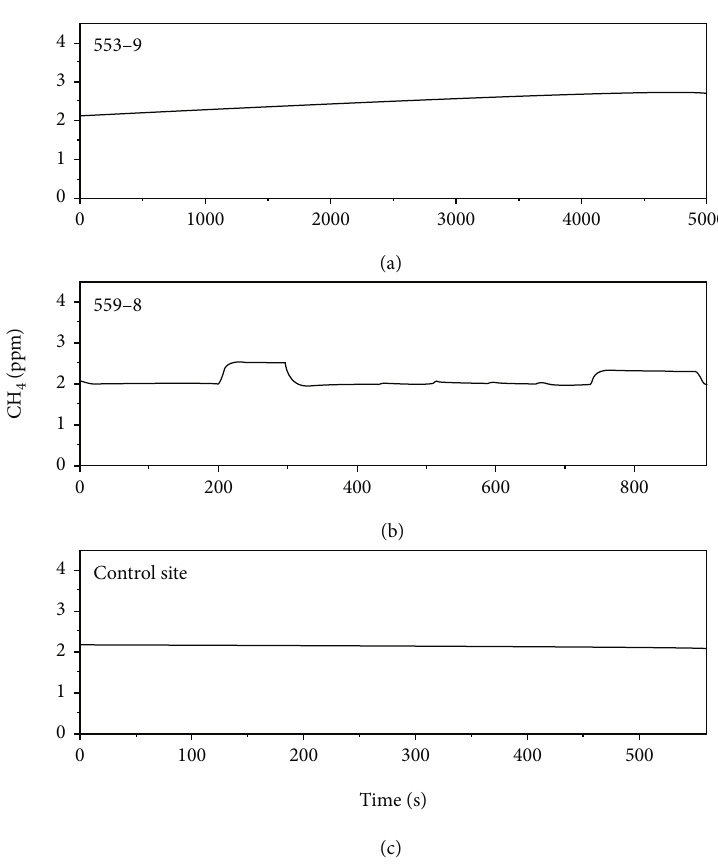
Figure 6: Flat release: (a) 553-9; (b) 559-8; (c) control